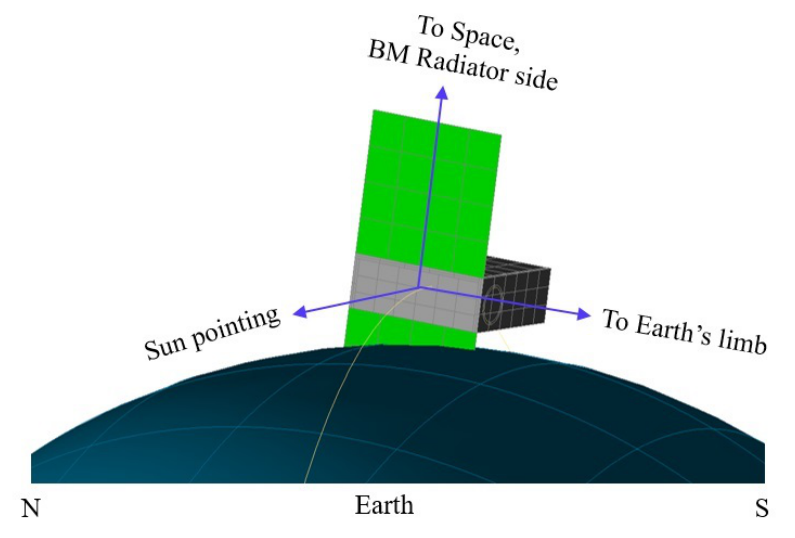
Figure 14. Satellite’s attitude in